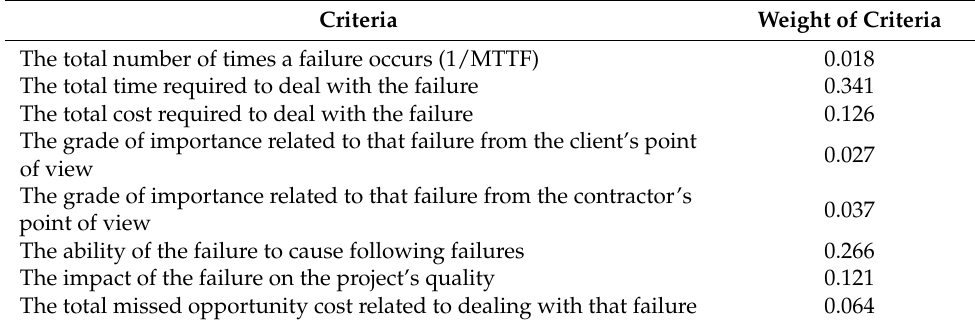
Table 4. Weight of criteria related to identifying the most critical potential failure. Criteria Weight of